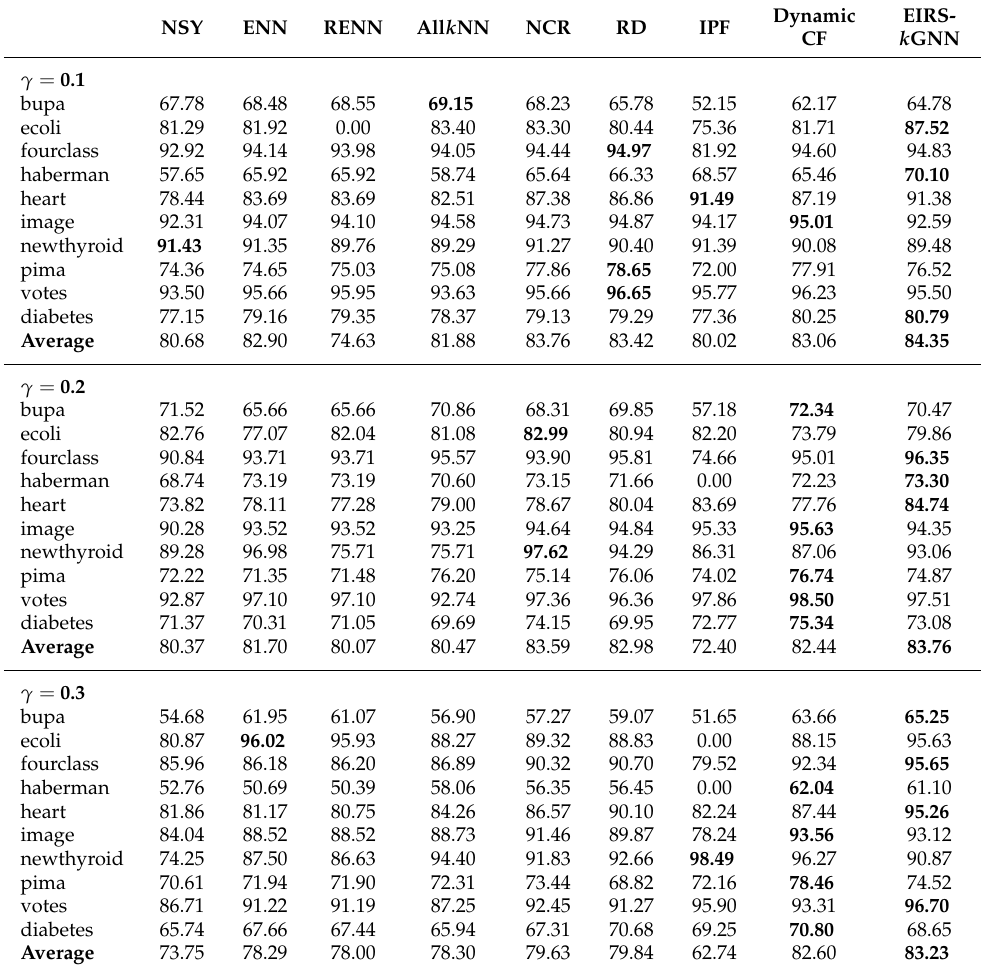
Table 3. Average AUC (%) comparison of classification results at varying γ